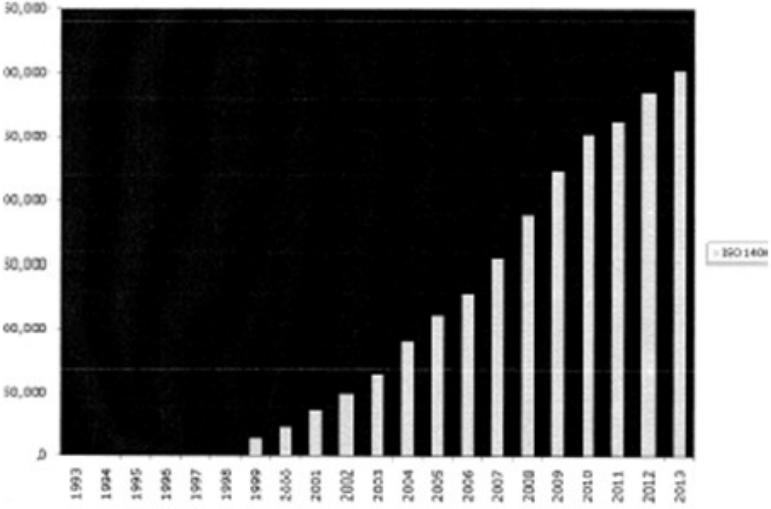
Figure 1. ISO 14001 certifications worldwide (ISO Survey